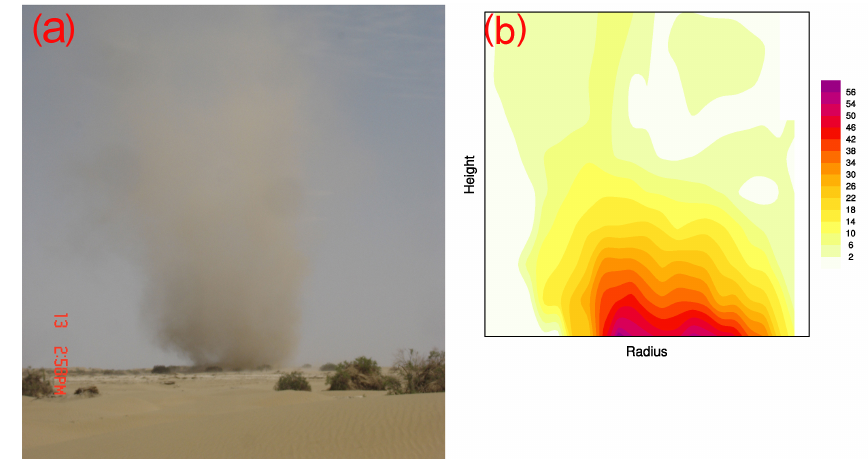
Figure 5. The DD observed on 13 July 2014 with (a) original photo and (b) the quantized DD’s opacity.